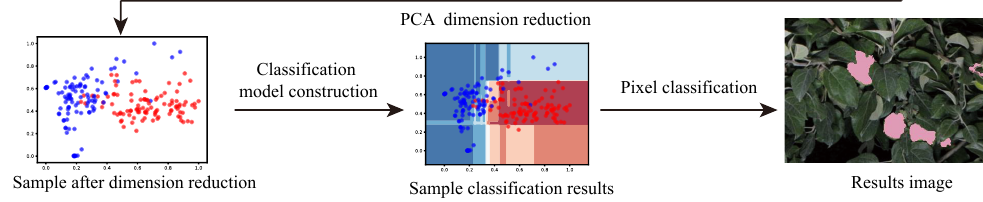
Figure 3. General steps of apple fruit segmentation